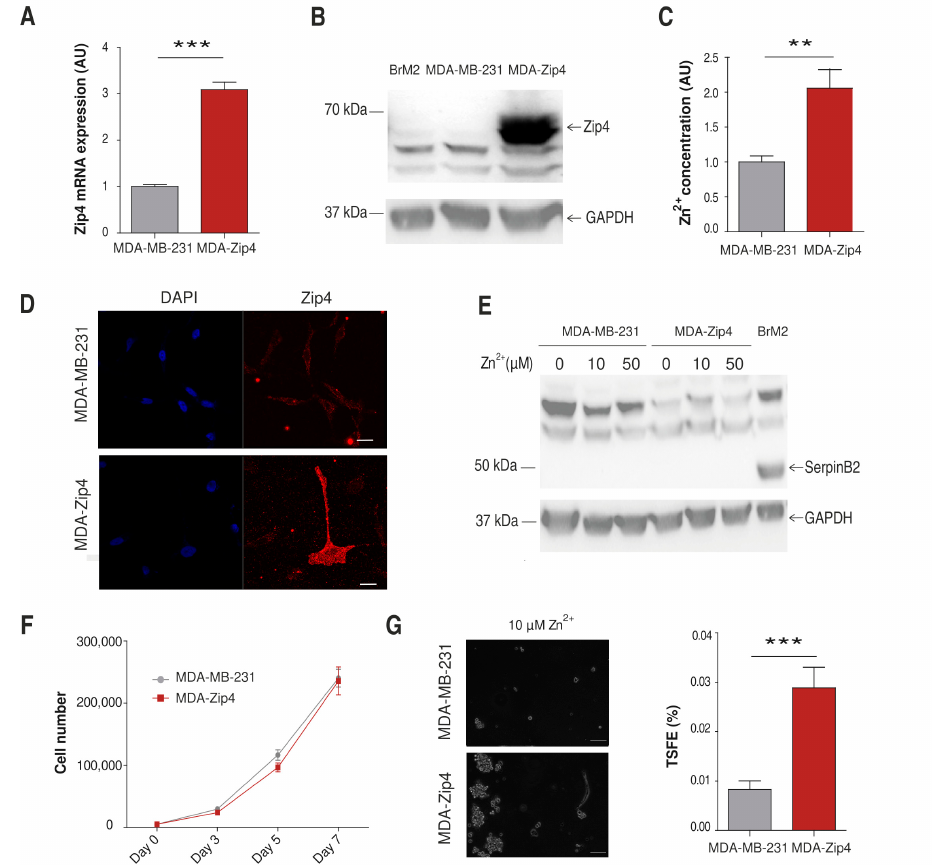
Figure 6. Characterization of the MDA-Zip4 cell line and Zip4 overexpression in the brain metastatic process. ( A ) RT-PCR comparing SerpinB2 expression in MDA-MB-231 and MDA-Zip4 cells in basal conditions. 2-DCT plotted using GAPDH as the housekeeping gene (n = 4); *** p < 0.005 using t -test. ( B ) Representative Western blot against Zip4 and GAPDH in MDA-MB-231, MDA-Zip4, and BrM2 cells. ( C ) Evaluation of zinc content by flow cytometry using Zinquin in 10 µ M of ZnSO 4 ( n = 9); ** p < 0.01 using t -test. ( D ) Representative pictures of MDA-MB-231 and MDA-Zip4 DAPI (blue) and Zip4 expression (red). Scale bar = 20 µ m. ( E ) Representative Western blot against SerpinB2 and GAPDH after 24 of treatment with 0, 10, and 50 µ M of ZnSO 4 in MDA-MB-231 and MDA-Zip4, and in BrM2 cells in basal conditions. ( F ) Proliferation analysis comparing MDA-MB-231 and MDA-Zip4 cells. Cells were counted on days 3, 5, and 7 ( n = 12–15). ( G ) Left, representative pictures of MDA- MB-231 (top) and MDA-Zip4 (bottom) tumorspheres formed with 10 µ M of ZnSO 4 after 21 days of differentiation. Scale bar = 100 µ m. Right, bar graph showing mean of TSFE for MDA-MB-231 and MDA-Zip4 cells ( n = 35–36); *** p < 0.001 using Mann–Whitney’s t